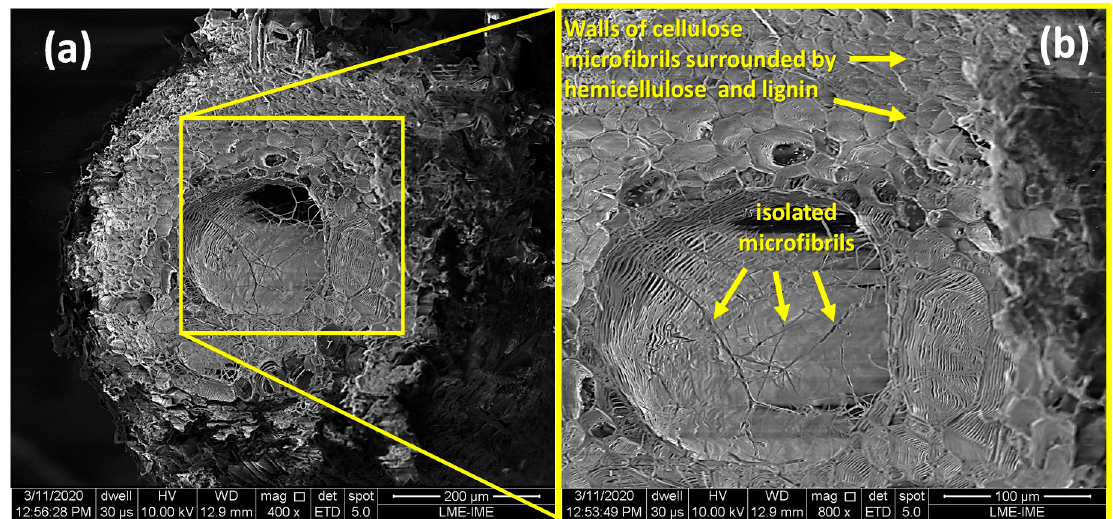
Figure 4. Scanning electron microscope (SEM) images: ( a ) 400 × and ( b ) 800 × of the cross section of a caranan fiber.